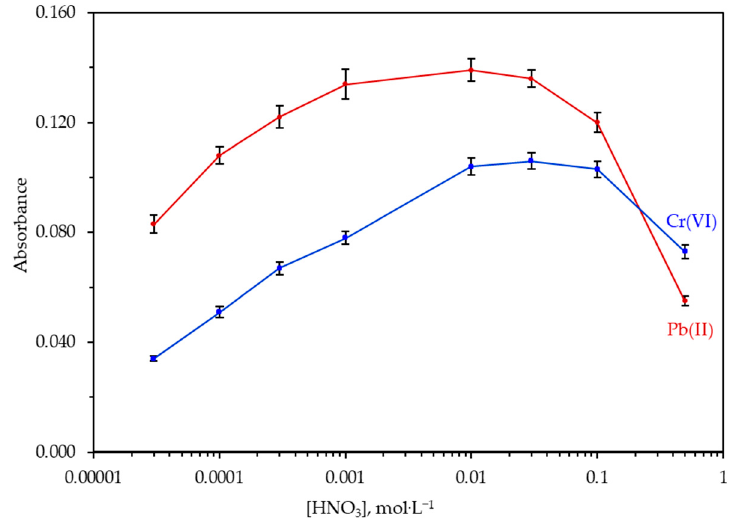
Figure 5. Effect of sample acidity on the absorbance of 100.0 µ g · L − 1 Pb(II) and 100.0 µ g · L − 1 Cr(VI). All the other experimental parameters are as presented in Table 1. Error bars were calculated based on standard deviation values ( n = 5).